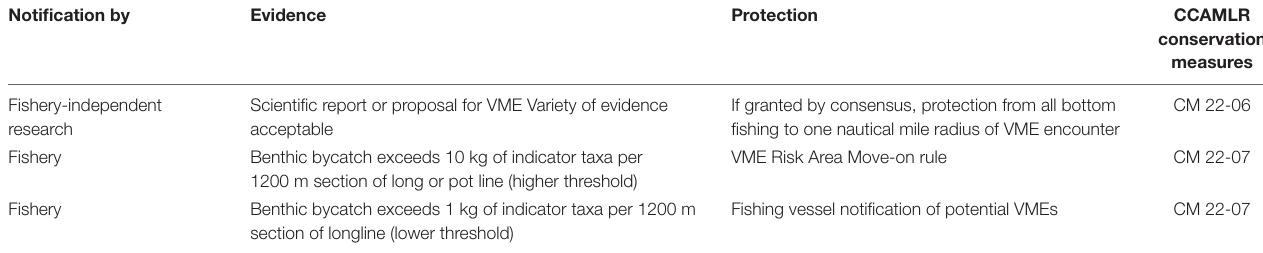
TABLE 2 | Vulnerable Marine Ecosystem (VME) encounter protocols within the CCAMLR area including evidence required and potential protection (CCAMLR,